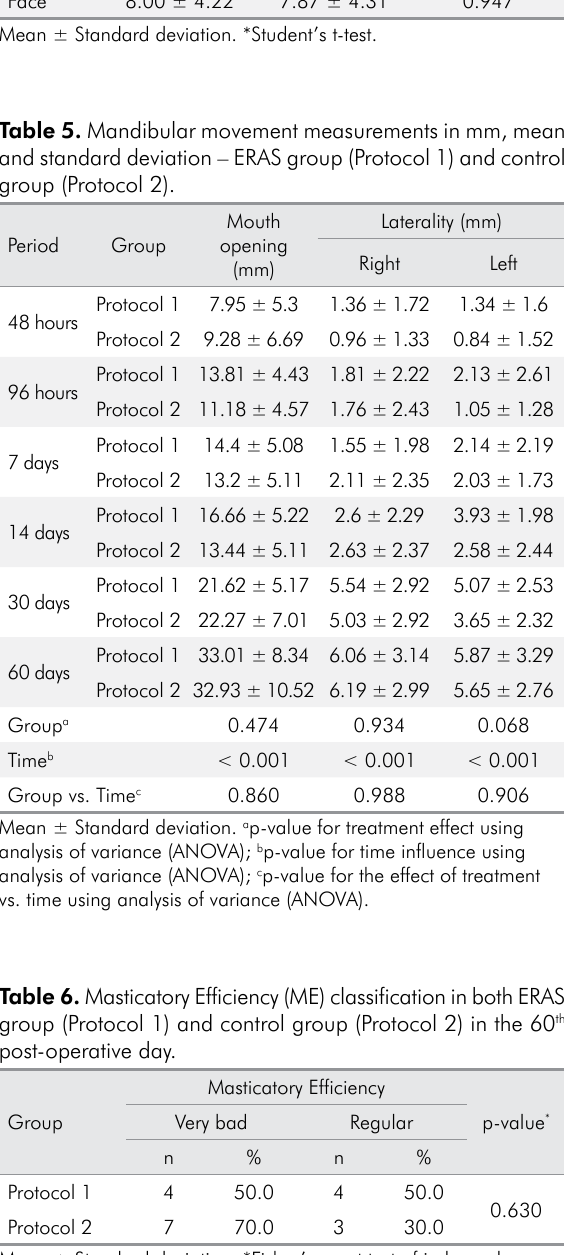
Mean ± Standard deviation. *Student’s t-test.